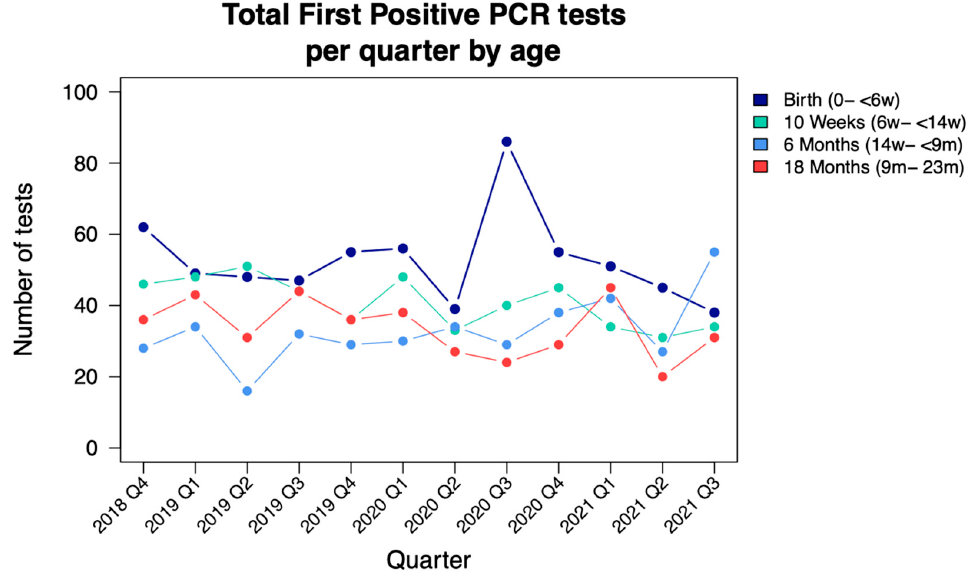
Figure 2. Children testing HIV PCR positive performed quarterly from October 2018 to September 2021, stratified by age; NICD data (d = days; w = weeks; m = months). According to the DHIS data, there was a total of 51,334 live births to WLHIV during the study period, with an average of 4278 live births to WLHIV per quarter. The decrease in positive HIV PCR tests translates to a declining annual case rate of newly diagnosed less than two-year-old infants and children of 905 to 804 per 100,000 live births. During the most stringent COVID-19 lockdown period viz. Q2 2020, there appears to be a decrease